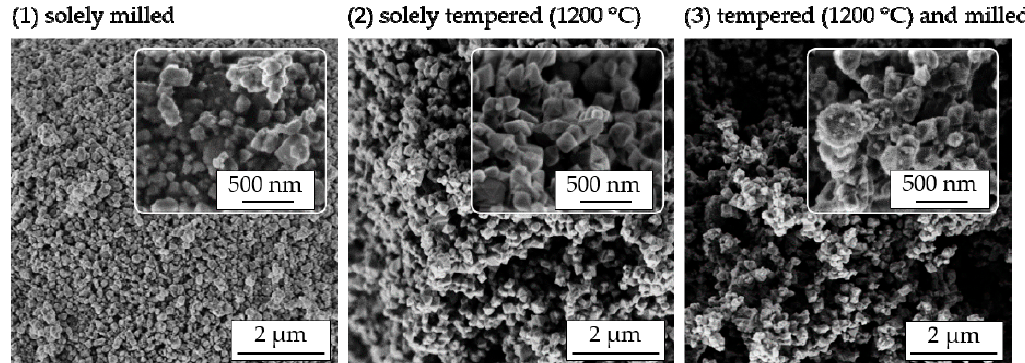
Figure 2. SEM images of GDC10 nanopowders after different powder pretreatments (insets use higher magnification): ( 1 ) Solely milled; ( 2 ) solely tempered at T PT = 1200 °C; and ( 3 ) tempered at T PT = 1200 magnification): ( 1 ) Solely milled; ( 2 ) solely tempered at T PT = 1200 ◦ C; and ( 3 ) tempered at T PT = °C and subsequently milled. 1200 ◦ C and subsequently